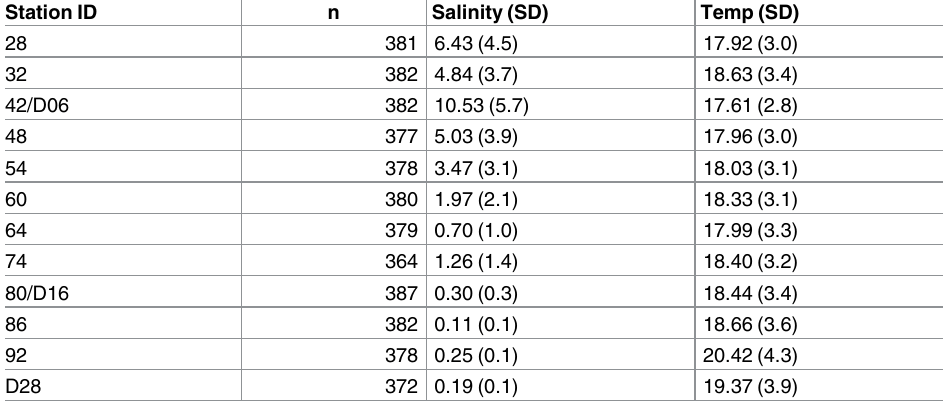
Table 1. Station IDs, the number of monthly CDFW mesozooplankton samples, mean salinity (psu) and mean temperature (˚C) for each site (SD in parentheses) sampled Mar-Nov from 1972–2015. The first 8 sites are considered brackish ( (cid:21) 0.55 psu) in our analysesand final 4 are freshwater ( < 0.55psu). Station ID